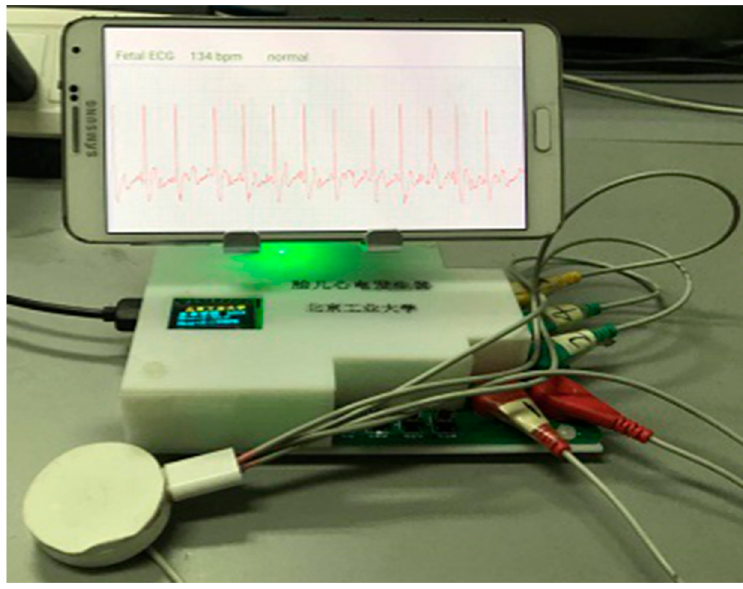
Figure 11. The fetal ECG monitoring system in operation.